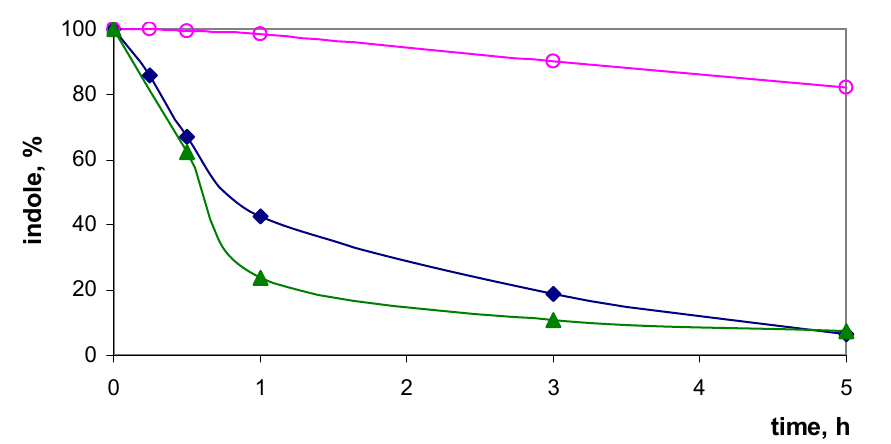
Fig. 4 Alkylation of indole potassium salt with different alkyl halides (in [mmim] [OTs] at 25 ◦ C) with: a) (cid:2) – 1-iodobutane; b) (cid:3) – 1-bromobutane; c) ◦ – 1- chlorobutane).